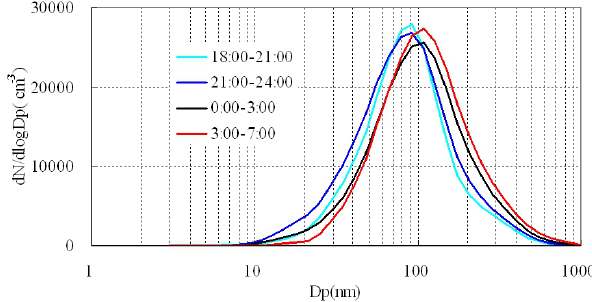
Fig. 4. Particle number size distributions during the accumulation pollution episode from 18:00 LT, 11 July to 07:00 LT, 12 July.